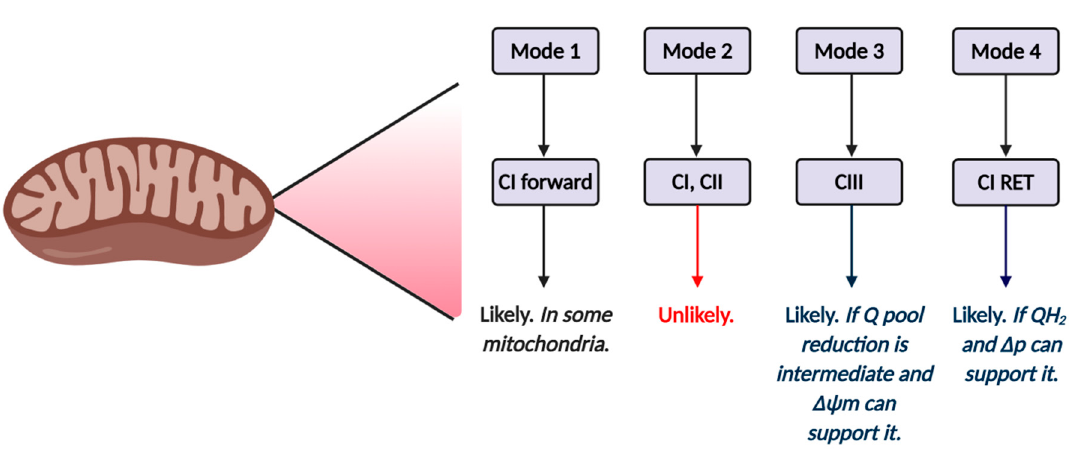
Figure 5. Tentative mechanisms of mitochondrial reactive oxygen species (ROS) production in ART by mode and site. Mode 1 (see Table 2) is likely to operate in at least some mitochondria, and is likely driven by complex I forward electron transfer. It is possible that complex II also operates in mode 1.